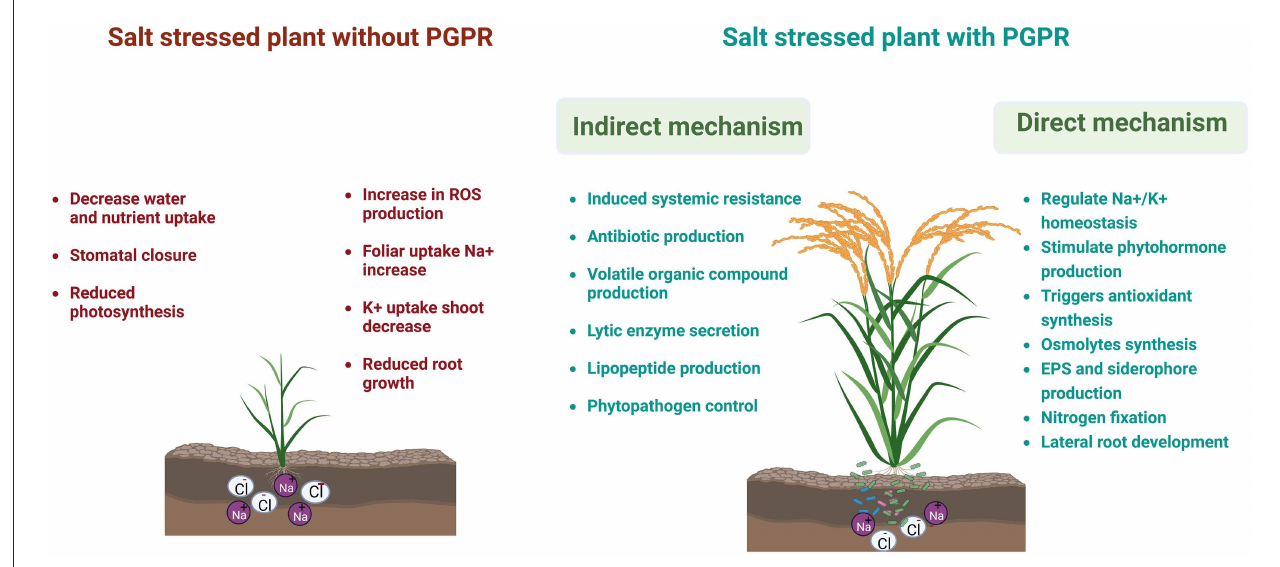
FIGURE1 An underlying mechanism of halotolerant plant growth-promoting rhizobacteria (HT-PGPR) in alleviating salinity stress in crop plants. Licensed from